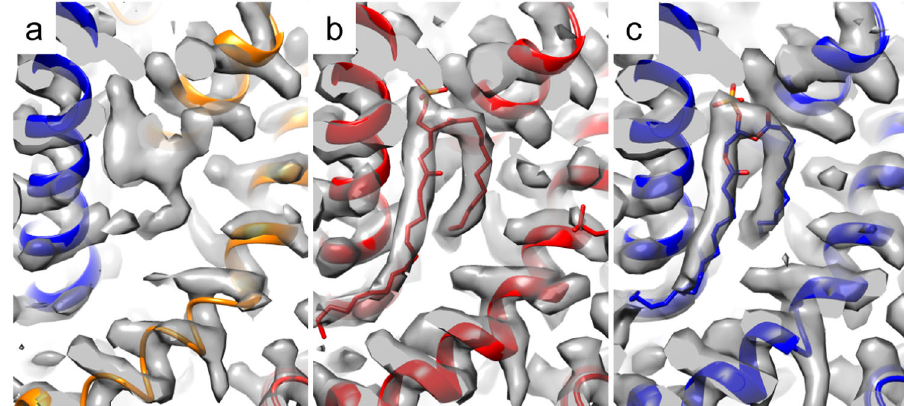
Fig. 2 Pico145 binds to a conserved TRPC4/5 lipid-binding site. a Density observed in our hTRPC5:Pico145 structure (100 µ M Pico145; contour level: 0.0621). b Equivalent density in the published mTRPC5 apo structure (PDB 6aei, EMDB 9615) that was modelled as a phospholipid (contour level: 0.0510). c The same site in the published mTRPC4 structure (PDB 5z96, EMDB 6901; contour level: 0.0331). Fitting Pico145 into the density shows that most of the TRPC5 substituting for the phospholipid phosphate group in the apo residues interacting with the inhibitor are from helix S5 and the structures. Pico145 ’ s xanthine core π -stacks with F576, and pore helix of the monomer on the right (monomer 1; Fig. 3a; several residues (including L521, Y524, C525 and V579) interact orange). The 3-hydroxypropyl substituent on N-1 of Pico145 with the 3-(tri fl uoromethoxy)phenoxy substituent on C8 of interacts with the side chains of W577 and Q573, apparently Pico145. The 4-chlorobenzyl substituent on N-7 of Pico145